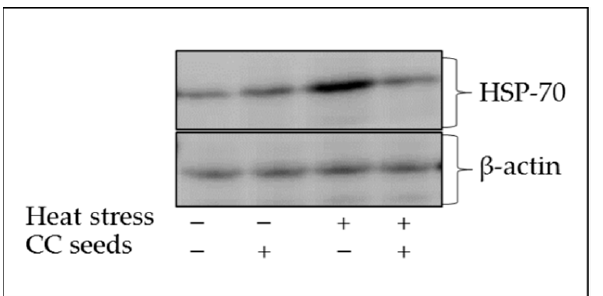
Figure 1. Blot of heat shock protein 70 (HSP-70) of broilers reared under thermo-neutral or cyclic heat-stress conditions and with or without Citrullus colocynthis (CC) seeds supplementation.